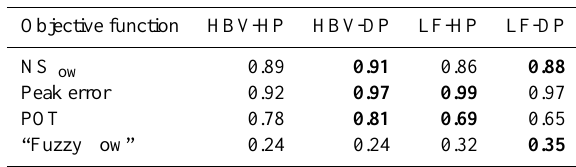
Table 1. Performance of the hydrological modes at Montford sta- tion. LF stands for the LISFLOOD-RR model and HP and DP are hourly and daily data, respectively. The best score for each rainfall- runoff model is highlighted in bold.